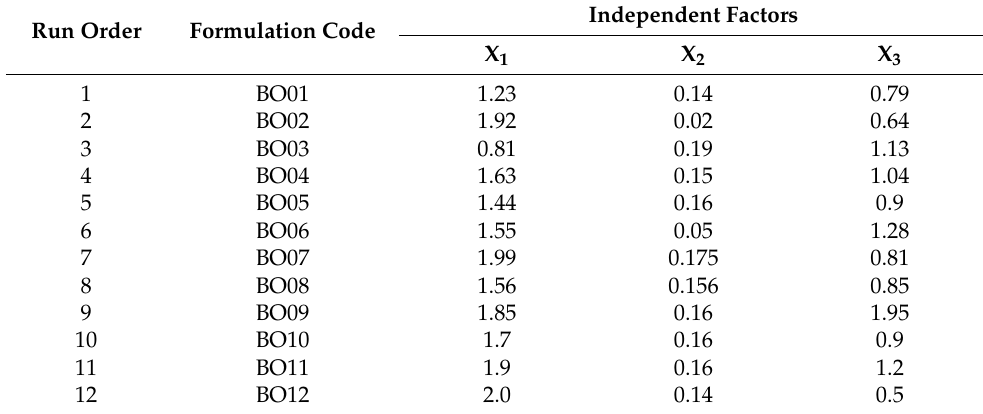
Table 3. The cumulative experiment design matrix proposed by BO. Run Order Formulation